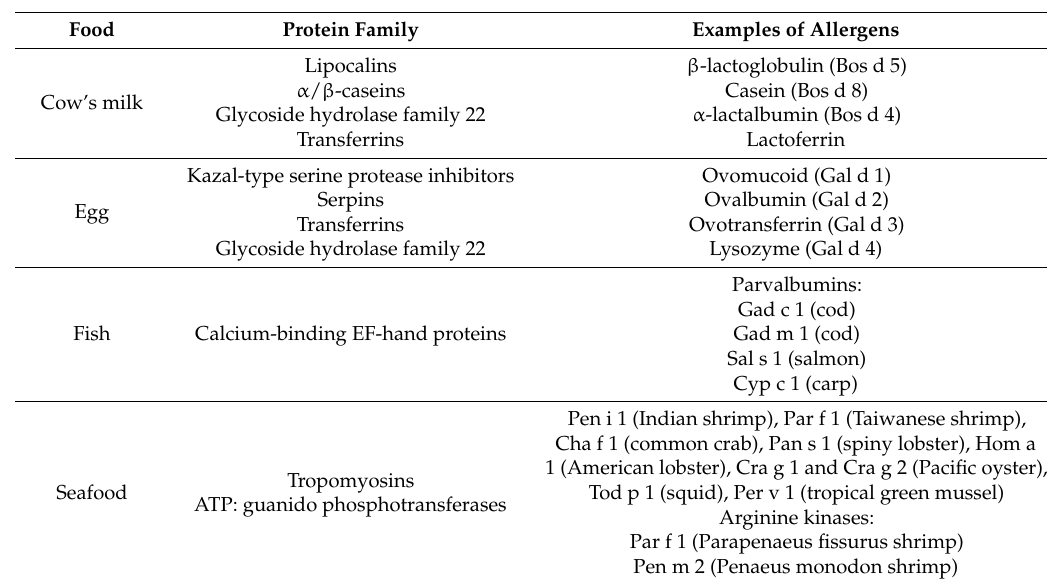
Table 3. Major food allergens from animal sources